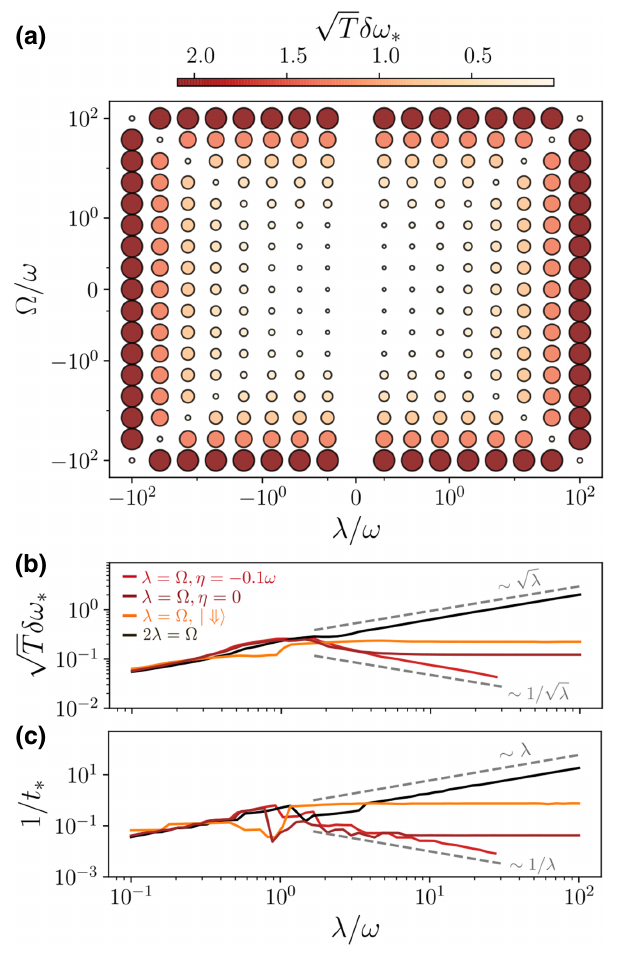
FIG. 4. (a) The optimized error δω ∗ is represented by both the size and color of the marker. The error is low when {| (cid:16) | , | λ |} (cid:19) ω , since this is close to the ideal case of noninteracting spins. More interestingly, the error is also low when | (cid:16) | = | λ | (cid:20) ω , corresponding to the regime of quantum many-body scarring. (b) As quantum scars emerge, the error decreases as δω ∗ ∼ | λ | − 1 / 2 for the inital Néel state | Z 2 (cid:2) (red lines). This is particularly clear when the scars are enhanced by the perturbation η = − 0.1 ω to the Hamiltonian [see Eq. (12)]. In contrast, outside the QMBS regime, the error increases as δω ∗ ∼ | λ | 1 / 2 (black line). For the initially polarized state |⇓(cid:2) ≡ |↓↓↓ · · ·(cid:2) the error plateaus, but does not decrease as λ increases (orange line). (c) As per- fect scars emerge, the optimal sensing time diverges as t ∗ ∼ | λ | . [Parameters (unless otherwise stated in legend): N = 16; (cid:2) , η = 0, ω = | ψ( 0 ) (cid:2) = | Z 2